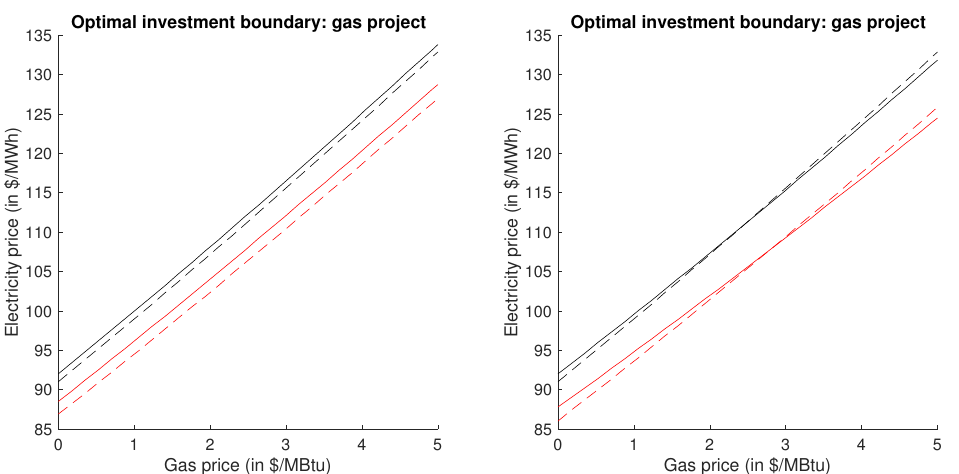
Figure 3. This figure displays the investment boundary for the gas-fired plant at t = 0 (black) and t = 0.3 (red) in case of low sensitivity of the gas price ( C = 0, left panel ) and of high sensitivity ( C = 2.5, right panel ). Solid line corresponds to the pandemic case, dashed line to the no-pandemic case. Parameter values are given in Table 1; the investment horizon is T = 1